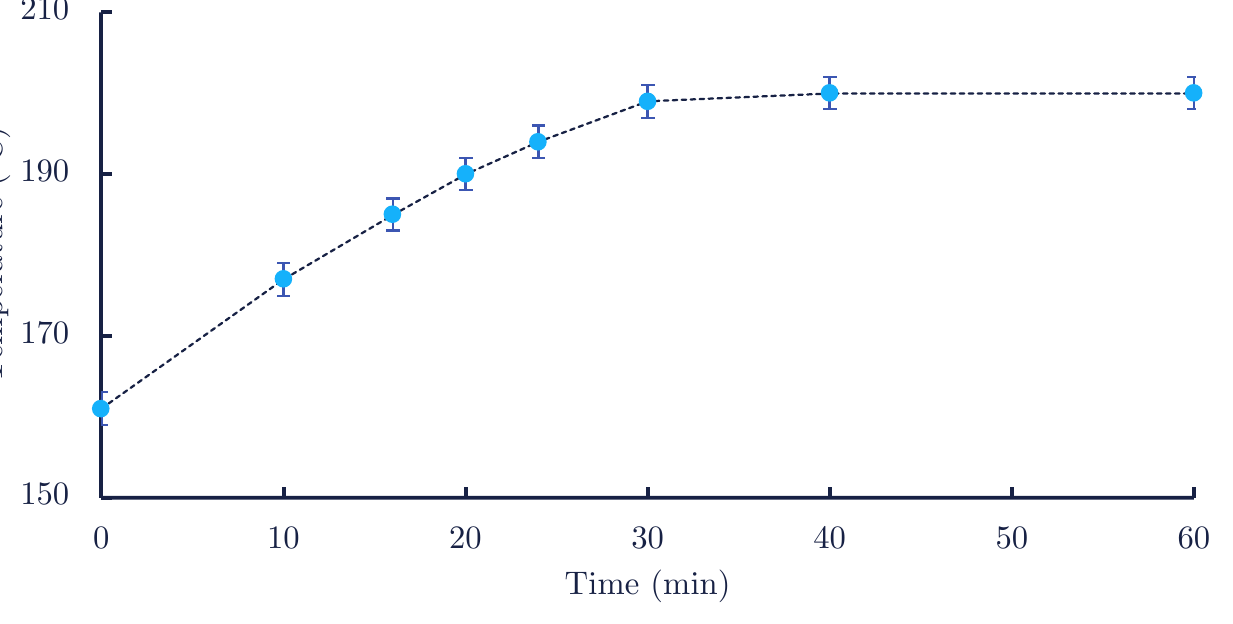
Figure A2. Temperature profile during heating in the experiments, assuming starting time to be once the block reaches 160 °C.